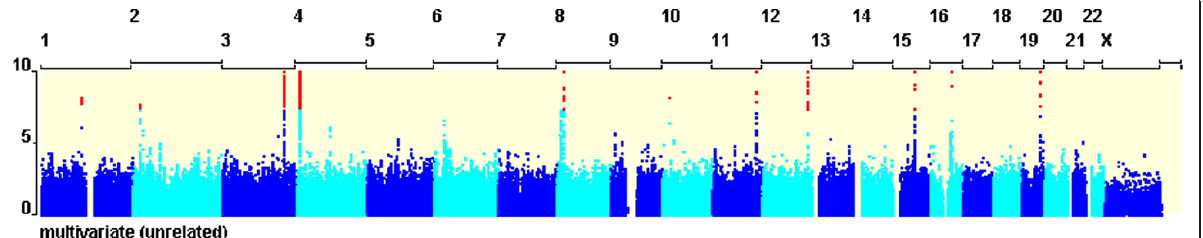
Figure 1 Manhattan plots for multivariate QTL analysis in unrelated-subject data (N = 4986) for the 13 traits . Genomic position is on the x-axis and the -log 10 of the association p-value is on the y-axis. Points with p-value of 5 × 10 -8 are shown in